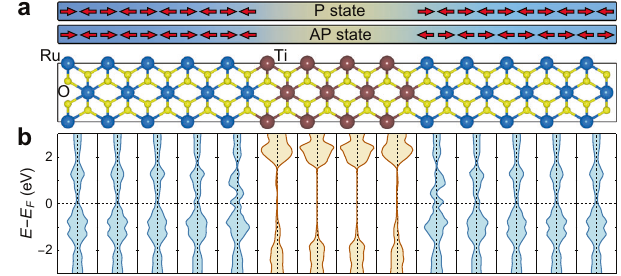
Fig. 3 Atomic and electronic structure of a RuO 2 /TiO 2 /RuO 2 supercell. a , b The atomic structure ( a ) and layer resolved density of states (DOS) ( b ) of the RuO 2 /TiO 2 /RuO 2 supercell. Each panel in b contains two atomic layers of MO 2 (M = Ru, Ti) and has left and right subpanels corresponding to up- and down-spin states, respectively. The arrows in ( a ) indicate the magnetic moments of Ru